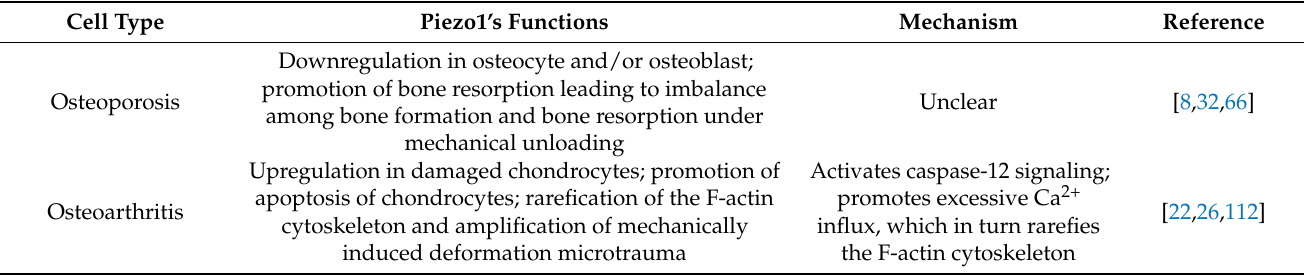
Table 3. The role of Piezo1 in bone disease and associated